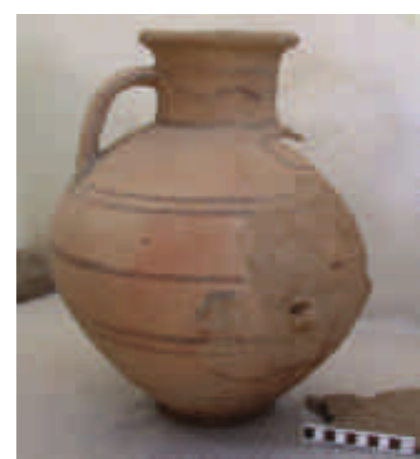
Figure 7 A decorated pot from the Kylindra infant cemetery